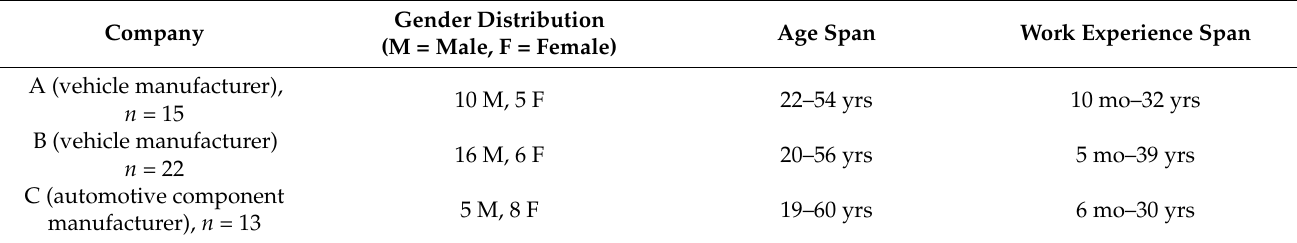
Table 1. Demographic information about the assemblers (total n =